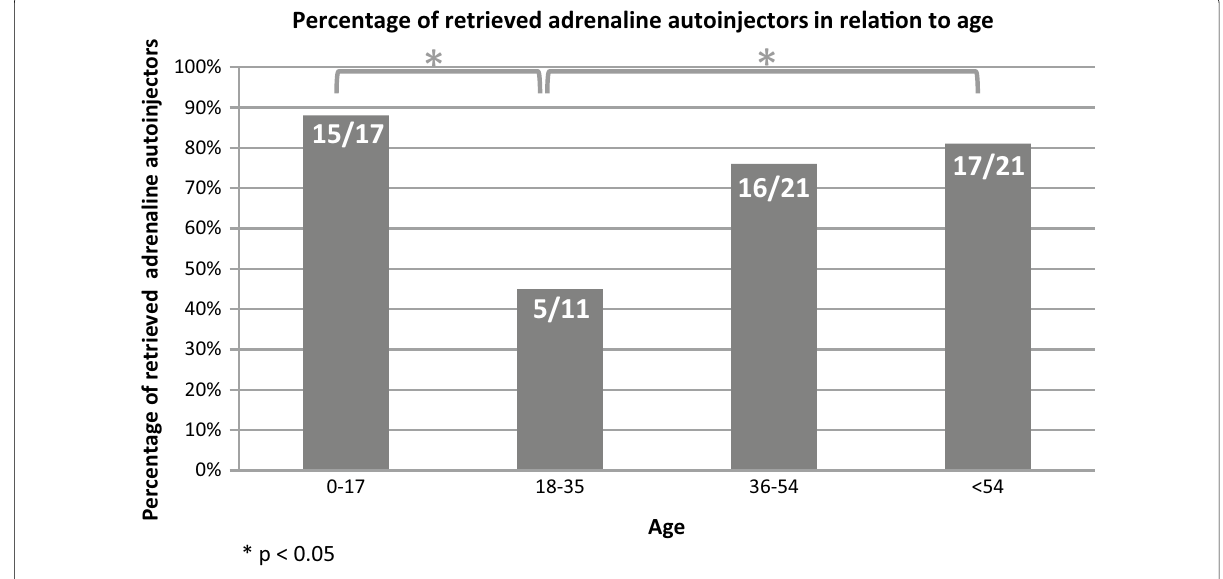
Fig. 1 Percentage of retrieved adrenaline autoinjectors in relation to